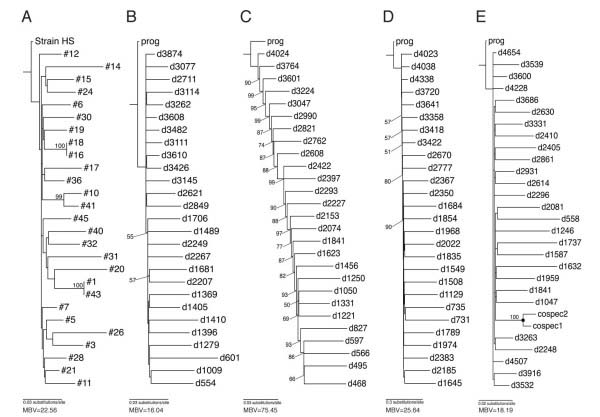
Bootstrapped ML trees derived from a reduced clade A dataset and sequences derived from evolutionary simulations. The tree depicting the reduced clade A dataset (panel A) comprises only strain HS and Columbicola spp. symbionts (with terminal nodes labeled according to the numbers listed in Additional File 5). Trees in panels B – E are derived from the output generated by simulation with evolutionary rates (substitutions/site/cycle) of 0.002 (progenitor) and 0.016 (descendants) for panel B and E , 0.016 for both the progenitor and descendants for panel C and 0.016 (progenitor) and 0.128 (descendants) for panel D. Terminal nodes representing the progenitor sequence are labeled “prog” and descendants are labeled with the prefix “d”, followed by the cycle number of their birth in the 5000 cycle simulation. The tree in panel E was obtained from a dataset in which one descendant was permitted to speciate at cycle 2500, giving rise to “cospec1” and “cospec2”. Mean bootstrap values (MBV), depicted at the foot of each tree were computed from bootstrap values obtained for all internal nodes in each tree. Only individual bootstrap values > 50% are depicted in the figure.